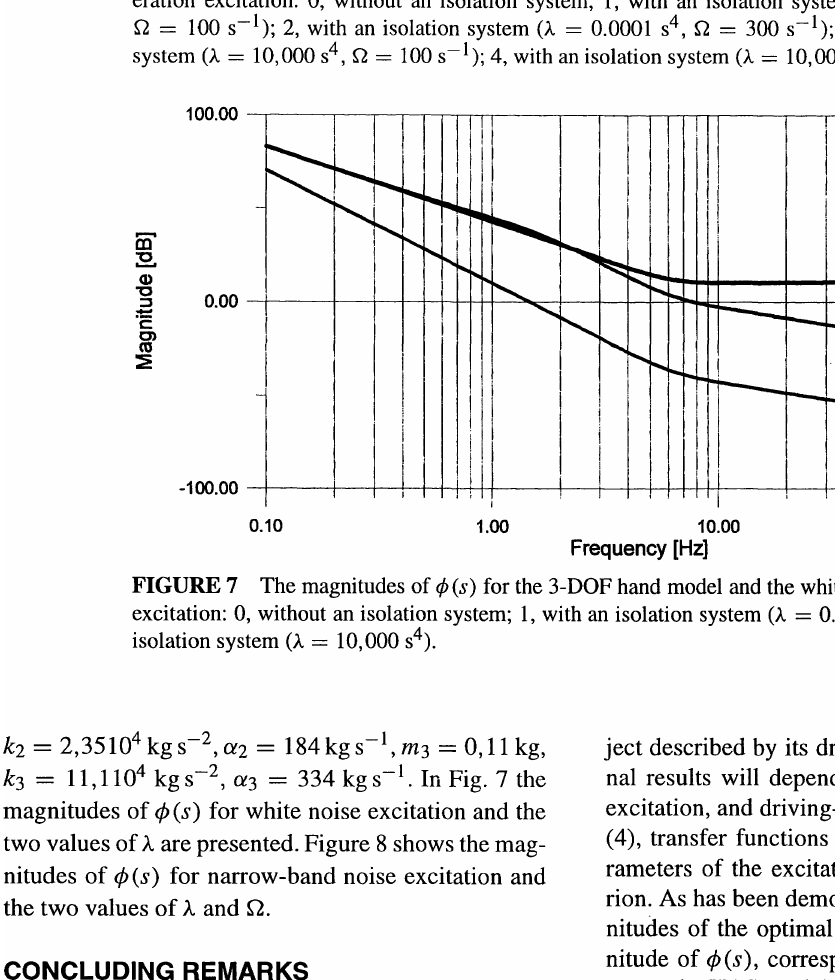
FIGURE 6 The magnitudes of <p(s) for the bent hand model and the narrow-band noise accel eration excitation: 0, without an isolation system; I, with an isolation system (). = 0.0001 s4, Q = 100 s-I); 2, with an isolation system (). = 0.0001 s4, Q = 300 s-I); 3, with an isolation system (). = 10,000 s4, Q = 100 s-I); 4, with an isolation system (). = 10,000 s4, Q = 300 s-I).